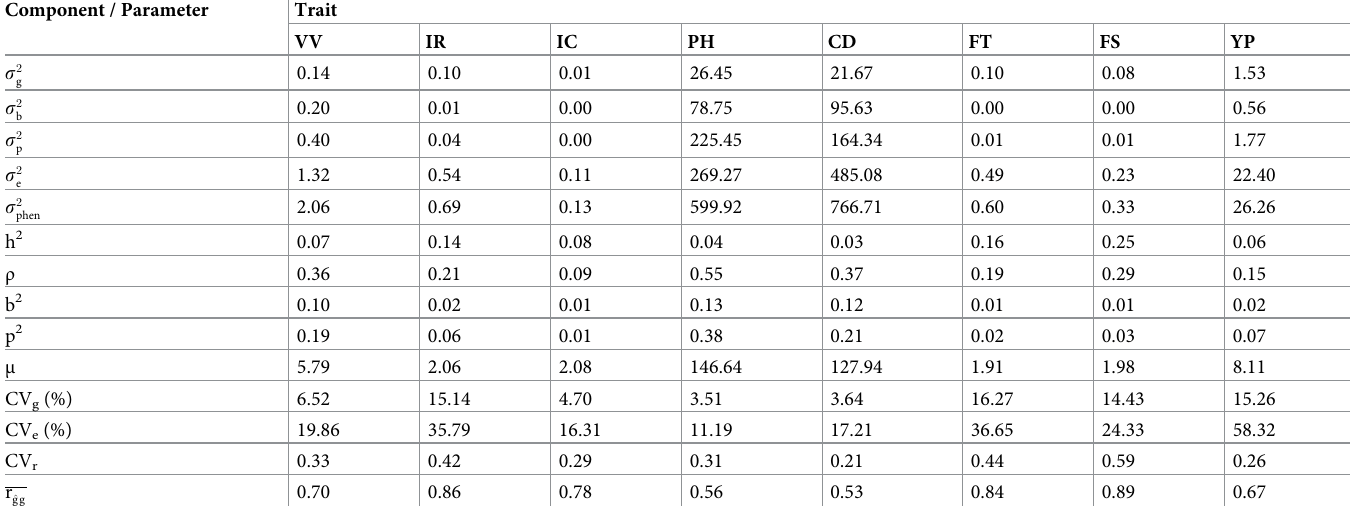
Table 2. Estimates of variance components and genetic and environmental parameters for the following traits: Vegetative vigor (VV), incidence of rust (IR), inci- dence of cercosporiosis (IC), plant height (PH), canopy diameter (CD), fruit ripening time (FT), fruit size (FS) and yield per plant (YP), evaluated in the conilon cof- fee population. Component /